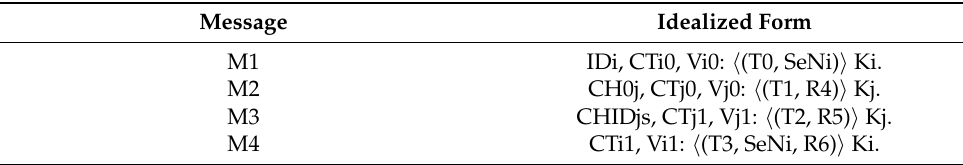
Table 5. Idealized form of the authentication and key agreement phase messages.